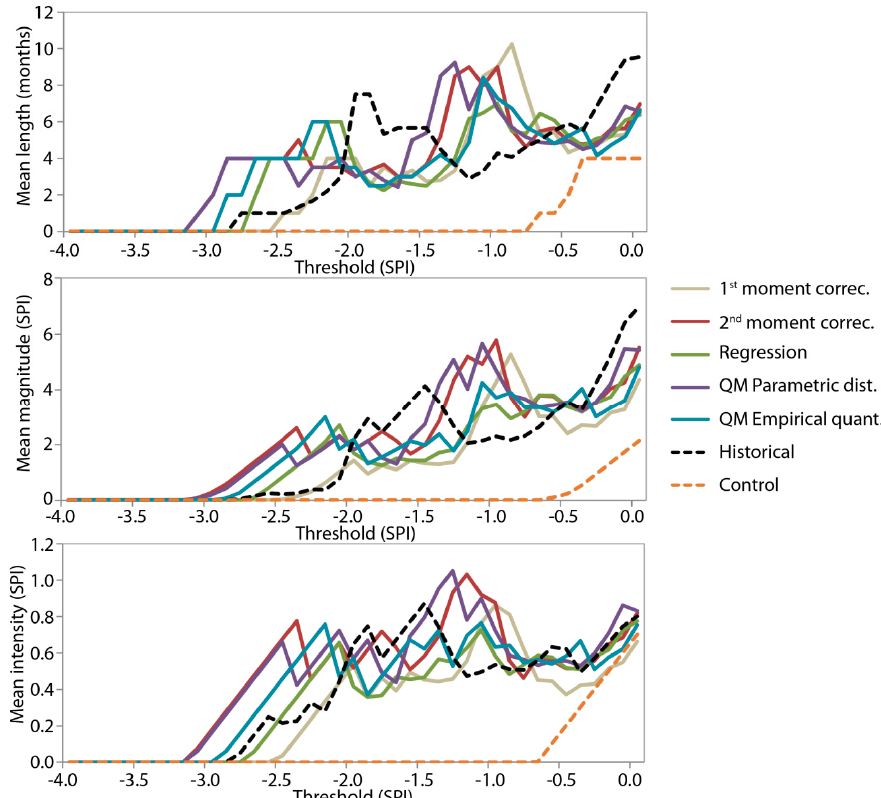
Figure 8. Drought statistics of the corrected precipitation control scenario (1971–2000) for the HIRHAM5 RCM model nested inside EC-EARTHGCM—lumped approaches.